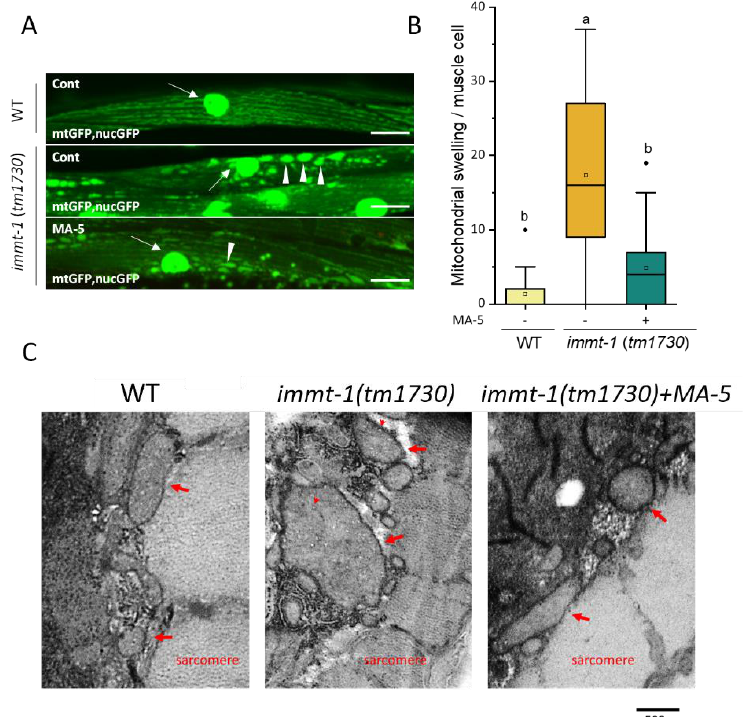
Figure 7. MA-5-induced suppression in mitofilin/ immt-1 gene mutation against abnormal mitochon- drial morphology. immt-1 (tm1730) null mutation ATU3307 worms expressing mitochondria-targeted green fluorescent protein (mtGFP) and nuclear-targeted GFP – LacZ (nucGFP) in body wall muscle cells were treated with or without MA-5 from L4 to adult stage on day 4. ( A ) Representative images of mitochondrial morphologies are shown (scale bar: 20 µm). White arrows indicate body wall muscle cell nuclei, and white arrowheads indicate abnormally swollen mitochondria. ( B ) The number of abnormal mitochondria in each muscle cell ( n ≥ 35 from 6 – 8 worms/treatment). Data are shown as box plots to indicate median (central line) and mean (square mark). Different letters indicate significant differences ( p ≤ 0.05) using Dunn’s test with all data points including outliers. ( C ) Observation of the mitochondria using transmission electron microscopy (scale bar: 500 nm). Red arrows indicate abnormal mitochondria and red arrowheads indicate abnormal cristae. WT: wild-type strain ATU3301 as mentioned before; Cont: control treated with 0.1% DMSO; MA-5: 10 μM; Diamond mark: outlier data.